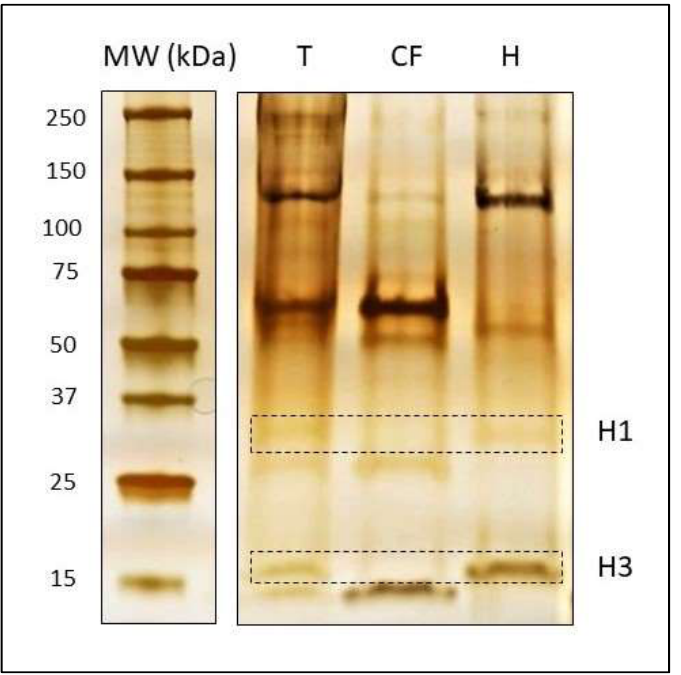
Figure 3. Silver staining of proteins after electrophoretic separation on 4 – 20% polyacrylamide gel. (MW) Molecular weight marker. (T) Total protein extract. (CF) Cytosolic fraction (concentrated CF1 + CF2). (H) Histone extract. Two micrograms of protein were loaded in each lane. All samples correspond to OA3.